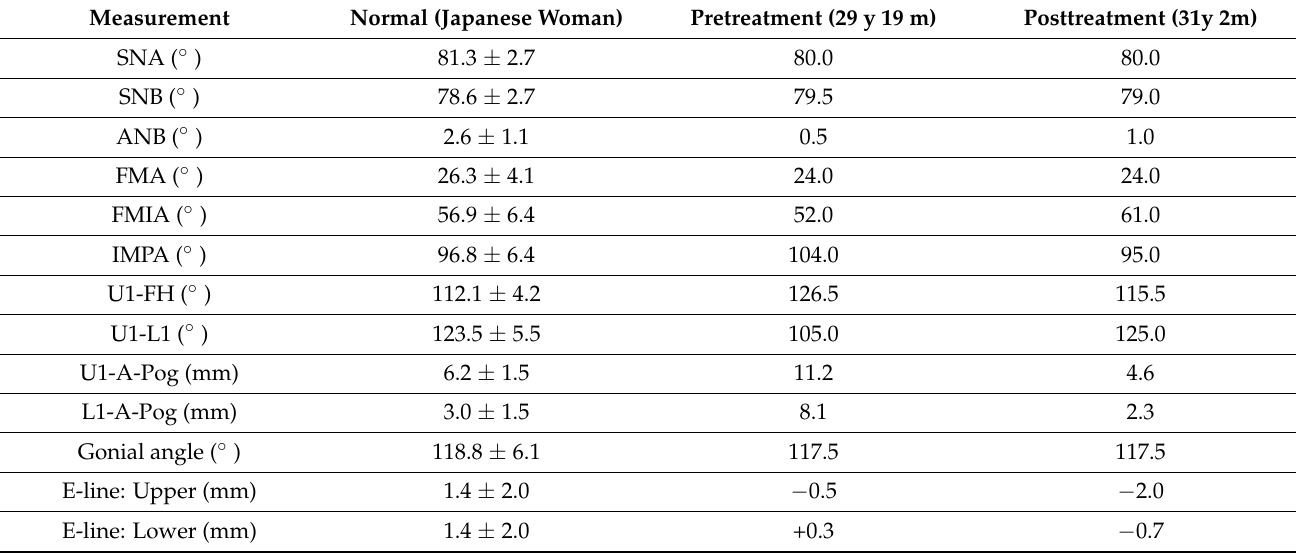
Table 5. Cephalometric analysis before treatment and